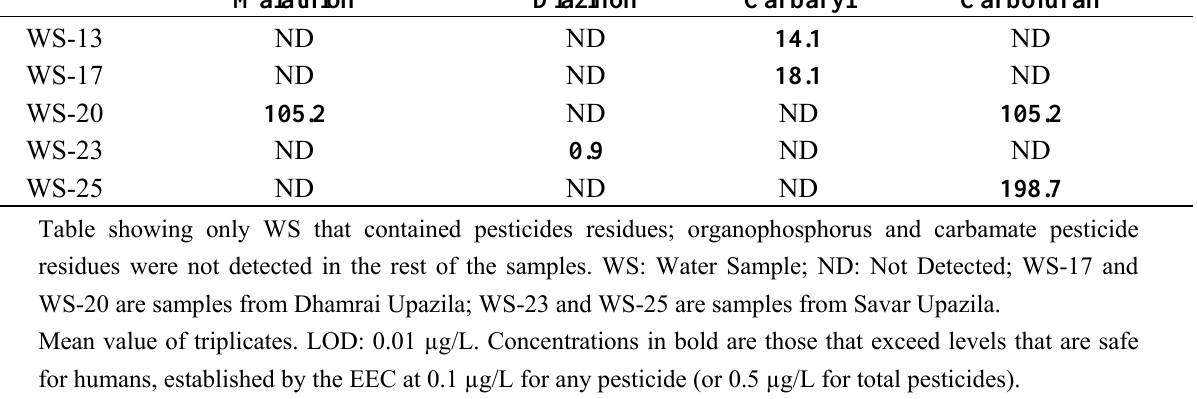
Table 3. Concentrations of Organophosphorus and Carbamate Pesticide Residues in Water Samples of Savar and Dhamrai Upazila.